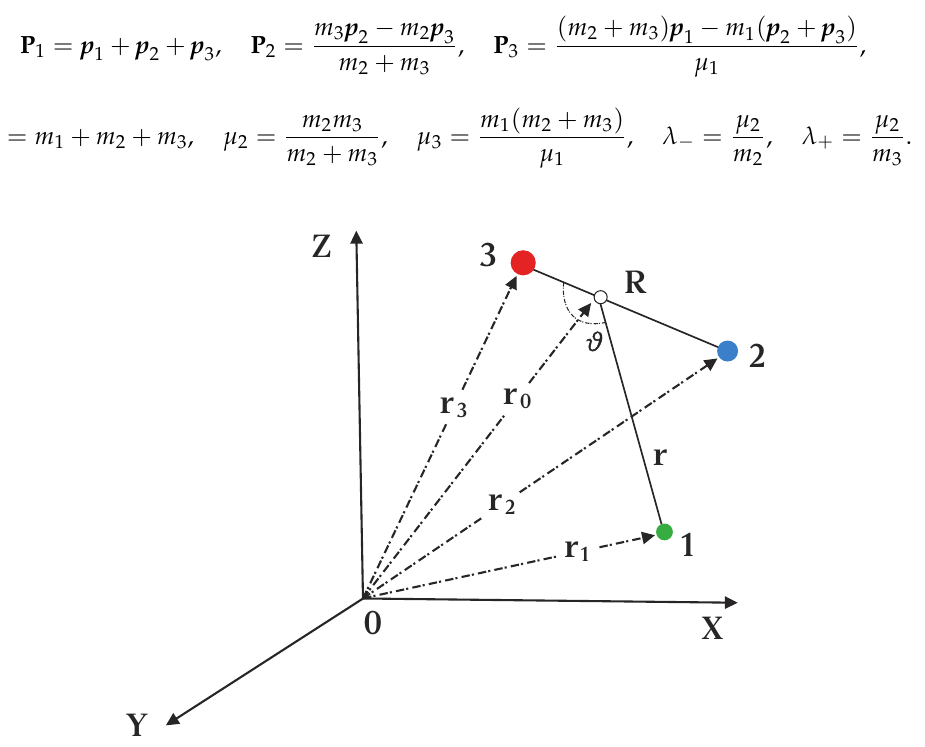
Figure 1. The Cartesian coordinate system where the set of radius vectors r 1 , r 2 and r 3 denote positions of the 1, 2 and 3 bodies, respectively. The circle “ ◦ ” denotes the center of mass of pair (23) which in the Cartesian system is denoted by r 0 . The radius vectors R and r determine the Jacobi coordinate system, and ϑ denotes the scattering